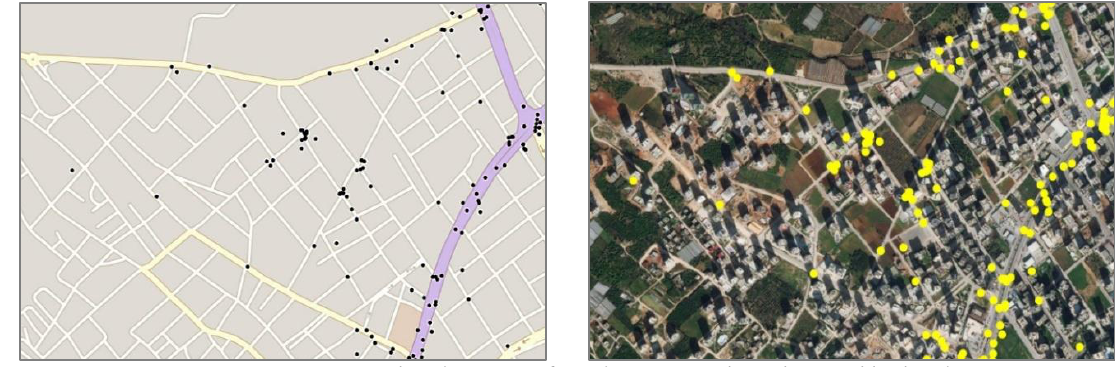
Figure 7 Street Network and Location of Accidents in Mezitli-Merkez Neighborhood